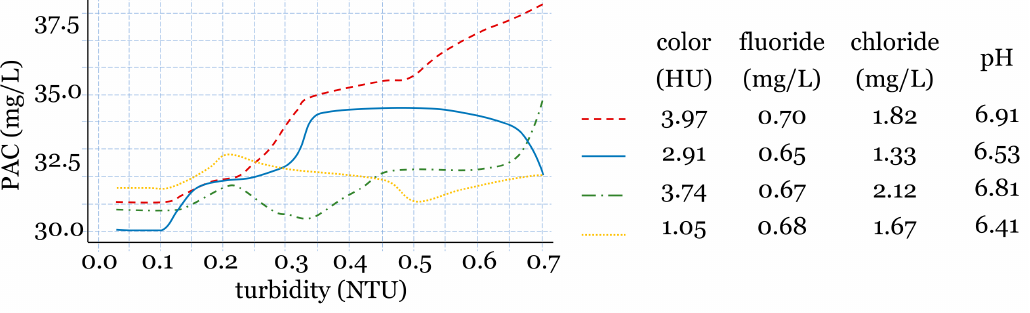
Figure 9. Impact on PAC prediction considering interdependent relationships between the water quality